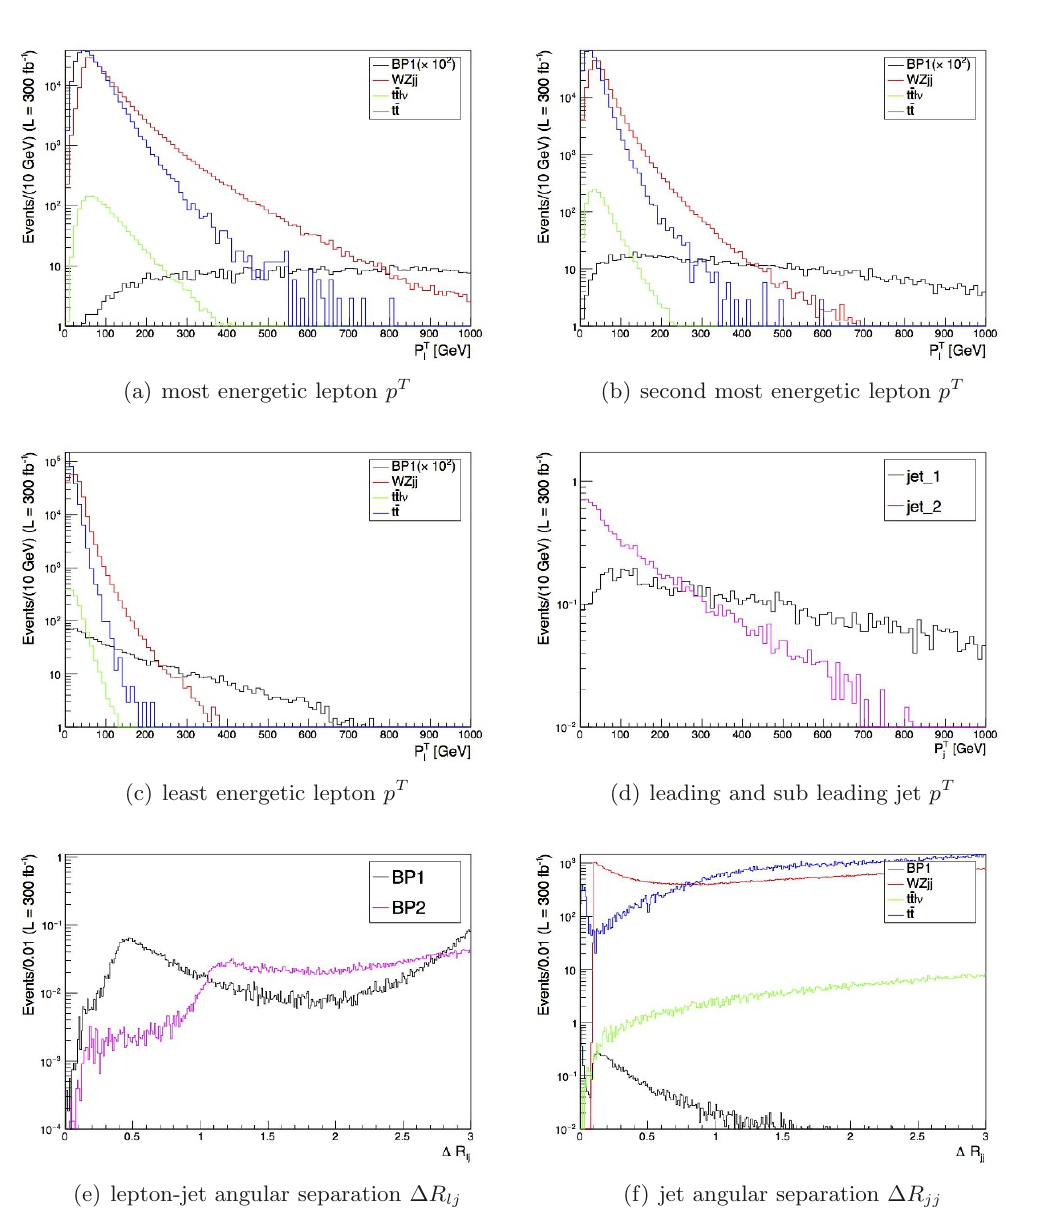
Figure 9 . (a) Distribution in the transverse momentum of the leading lepton. The black solid line is the signal, the red line the WZjj background, the green and the blue lines the t ¯ tlν and t ¯ t SM background components. (b) same as (a) for the second most energetic lepton. (c) same as (a) for the least energetic lepton. (d) Distribution in the transverse momentum of the two jets in BP1. Black and magenta lines refer to the leading and sub-leading jet, respectively. (e) Distribution in the angular separation between any jet and lepton averaged over the six possible pairs. The black and magenta lines refer to BP1 and BP2, respectively. (f) Distribution in the angular separation between the two jets. The color code is the same as for plot (a). All distributions are calculated for the benchmark point BP1 (except plot (e)) for a luminosity = 300 fb − 1 L